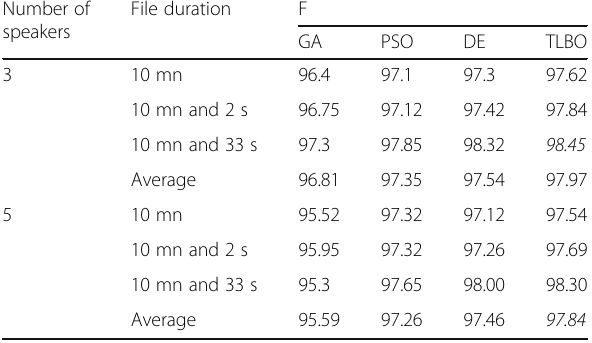
Table 8 Segmentation results using NDTV dataset Number of speakers